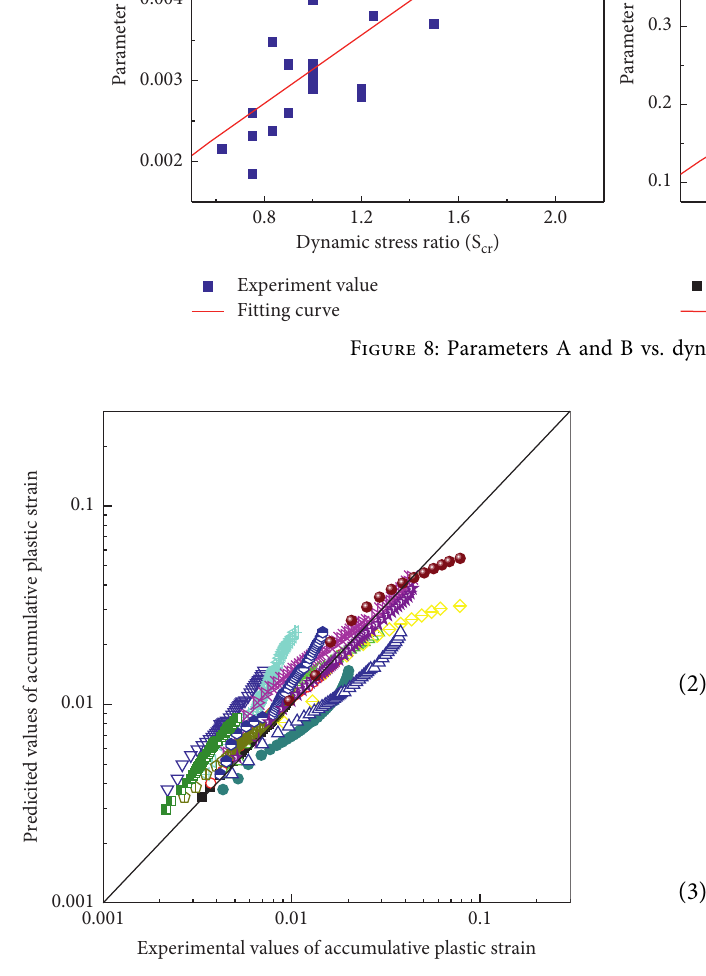
Figure 9: Comparison of predicted and experimental values of accumulative plastic